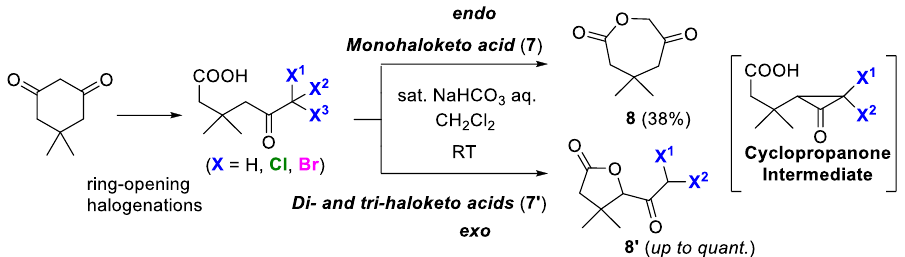
Figure 5. Endo / exo -selective dehalolactonization reactions of haloketo acids 7 and 7′ controlled by the internal halogen groups.